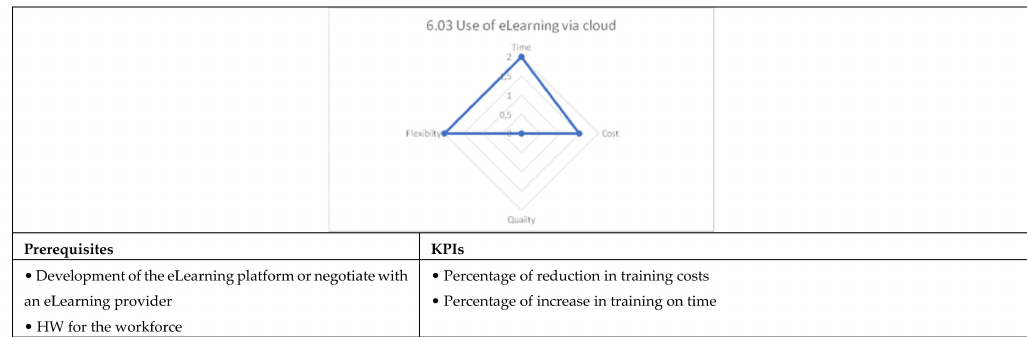
Figure A41. Use of eLearning via cloud data sheet.